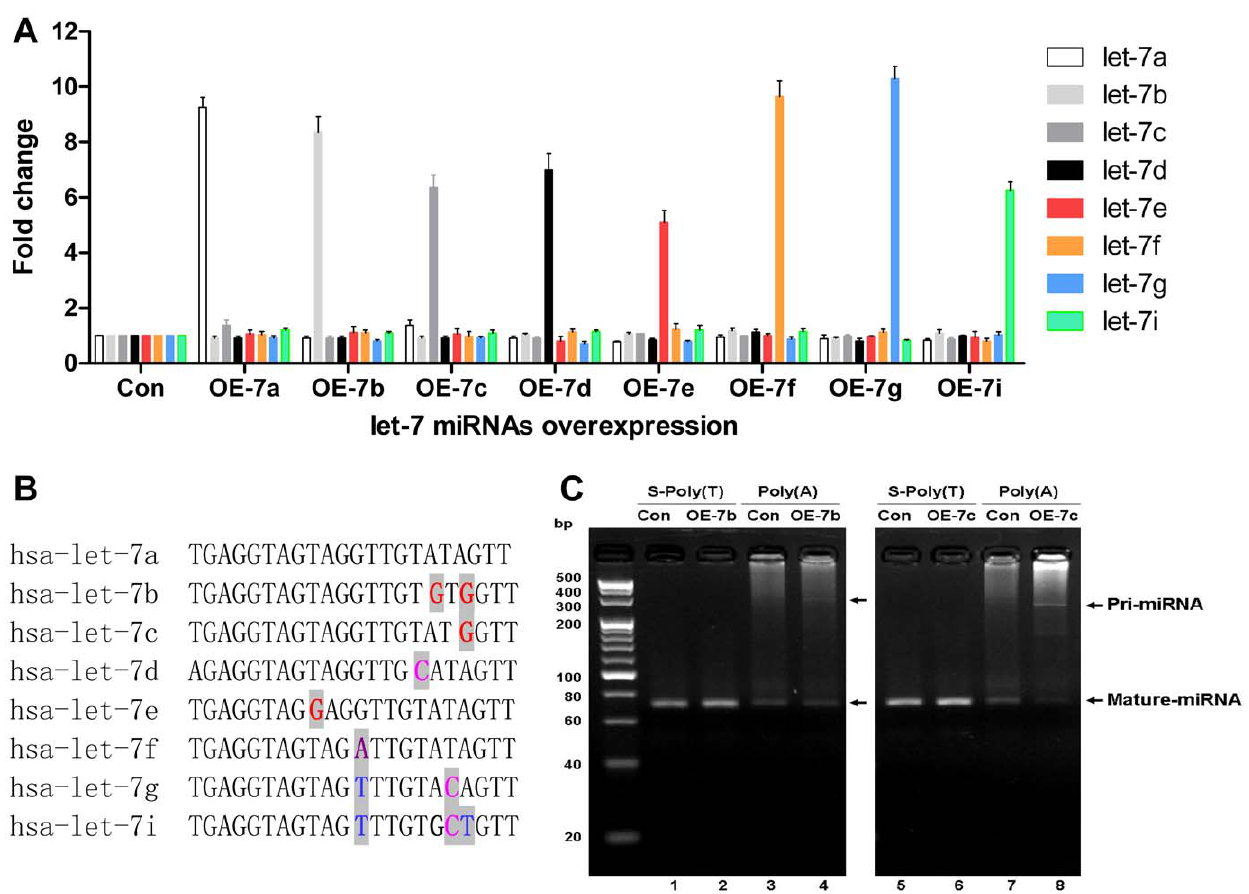
Figure 4. Specificity of the S-Poly(T) method in human let-7 family miRNAs assay. A: Eight hsa-let-7 miRNAs (let-7a, let-7b, let-7c, let-7d, let-7e, let-7f, let-7g, let-7i) were individually over-expressed in HEK293 cells by a lentiviral vector. The expression levels of the eight hsa-let-7 miRNAs were compared between the control (transduced with blank lentiviral vector) and the hsa-let-7 miRNAs-overexpressing HEK293 cells. The expression level of each hsa-let-7 miRNA in the hsa-let-7 miRNAs-overexpressing HEK293 cells (OE-7a , OE-7i) was shown as the fold change compared with that in the control (Con). B: sequence alignment of eight hsa-let-7 miRNAs. Non-conserved nucleotides are shaded. C: discrimination of mature miRNA from pri- and/or pre- miRNA by the S-Poly(T) and Poly(A) methods. The total RNA overexpressing hsa-let-7b and hsa-let-7c were reverse transcribed to cDNA by the S-Poly(T) and Poly(A) methods, respectively. The PCR products were run on 4% agarose gel in sodium borate (SB) buffer. The arrows indicate the amplification products of pri- and mature miRNAs.